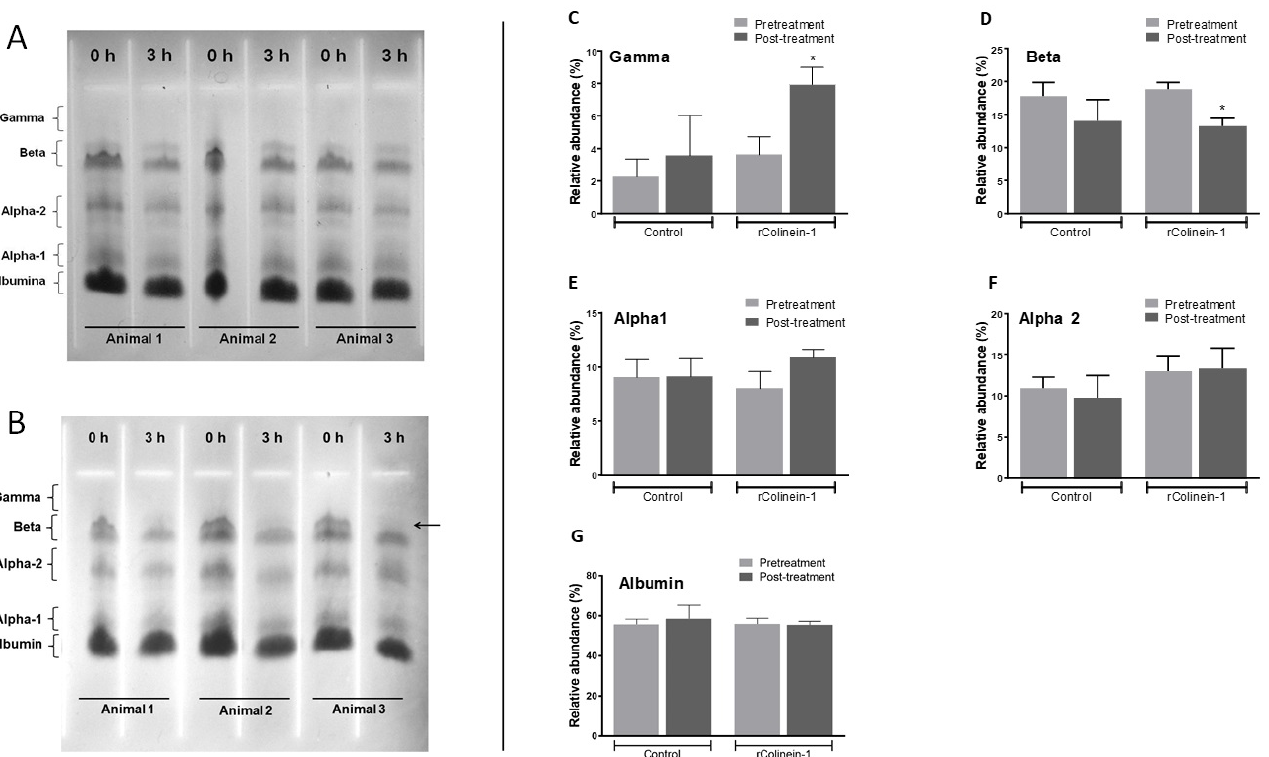
Figure 5. Effect of rCollinein-1 on plasma protein. Plasma proteins of animals not treated (a) and treated (b) with rCollinein-1 (1 mg/kg) were evaluated by agarose gel electrophoresis. After 3 h of intraperitoneal injection, the animals were anesthetized, and the blood was collected by cardiac puncture in the presence of sodium citrate. Prior to treatment, an aliquot of blood was collected from each animal by a small incision in the tail and the sample was used as 0 h. The collected blood was centrifuged at 500 x g , the plasma (0.4 μL) was applied on an agarose gel, which was then stained with black starch. The arrow indicates the fade of the first band of beta-globulin zone. Relative abundances of Gamma (c) , Beta (d) , Alpha-1 (e) , Alpha-2 (f) and albumin (g) zones were determined by densitometry of the electrophoretic bands. * p < 0.05 compared to pretreatment